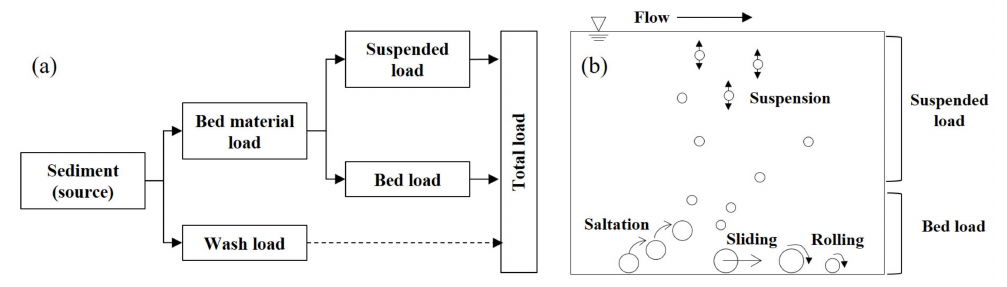
Figure 1. Classification of sediment transport. ( a ) Classification of sediment; ( b ) sediment transport